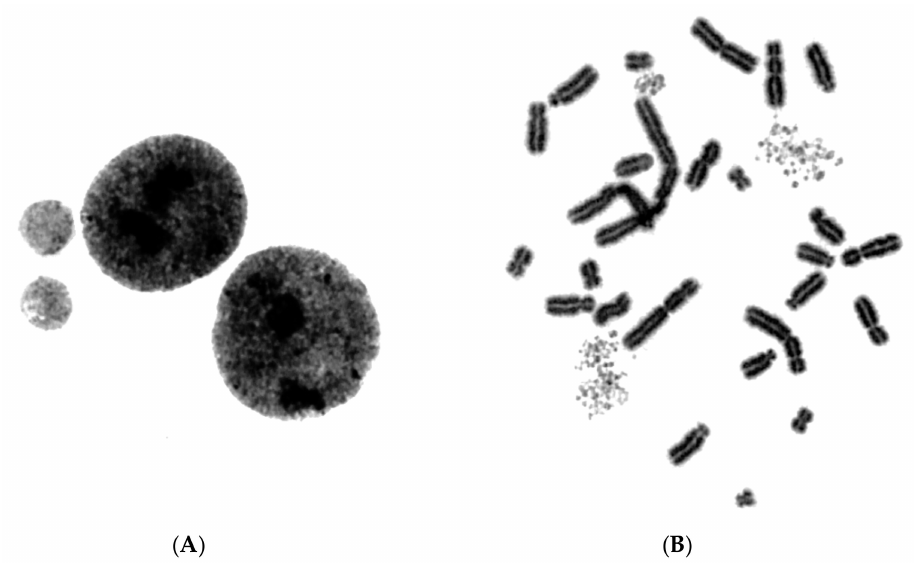
Figure 3. MN PCCs are visualized only when main nuclei enter mitosis. Through rigorous cytogenetic assessment, more than a thousand heterophasic micronucleated cells per experimental point were analyzed for nuclear envelope rupture and shattering of chromosomal material entrapped in